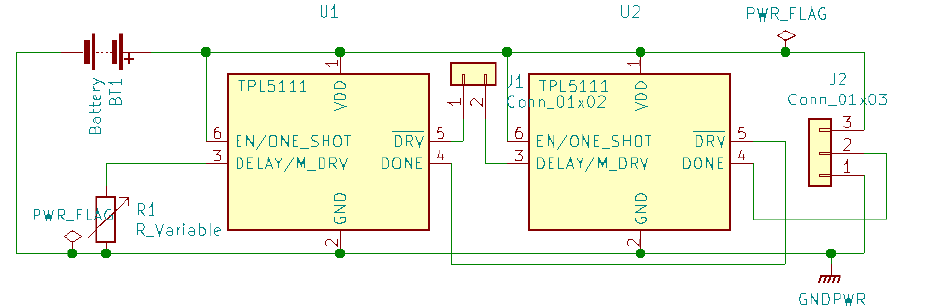
Figure 10. Mechanical wake-up with delay